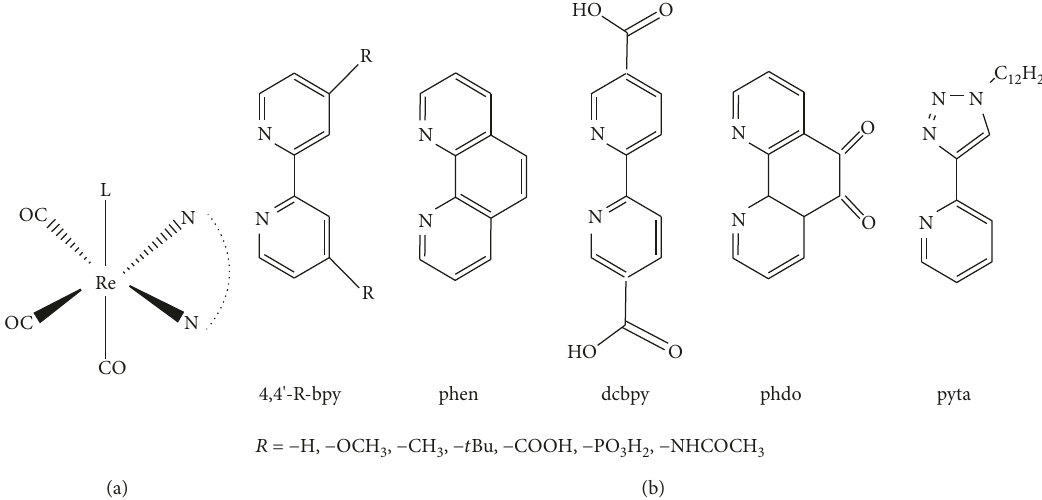
Figure 4: (a) General structure of Re(I) complexes. (b) Some typically NN ligands (bpy=2,2 ′ -bipyridine, phen=1,10-phenanthroline, dcbpy=5,5 ′ -dicarboxylic acid-2,2 ′ -bipyridine, phdo=5,6-dione-1,10-phenantroline, and